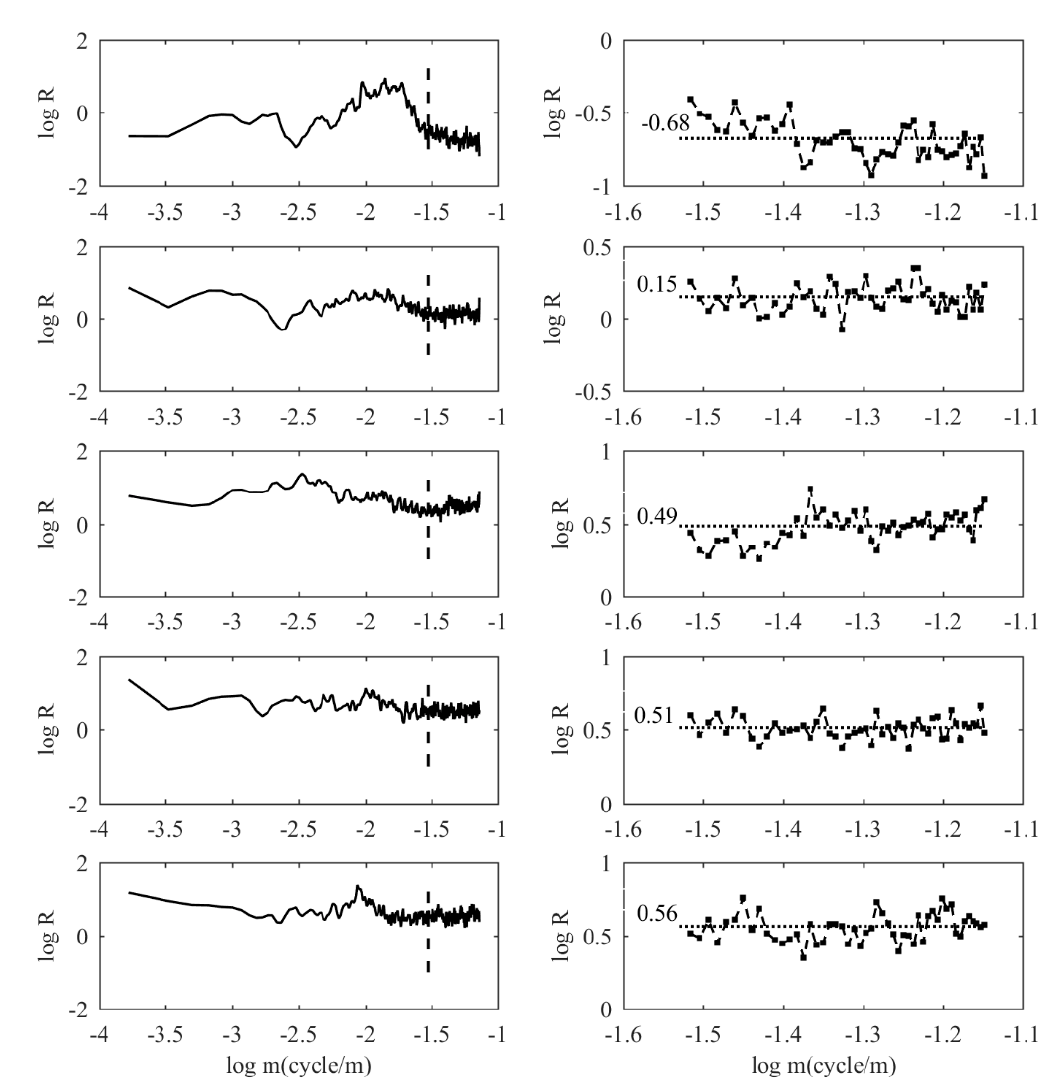
Figure 8. Distribution of R with wavenumber (left panel), averaged R value after filtering out noise and turbulence in the interval to the right of m (right panel). From top to bottom are height ranges of 2–8 km, 14–20 km, 20–26 km, 26–32 km, and 32–38 km.